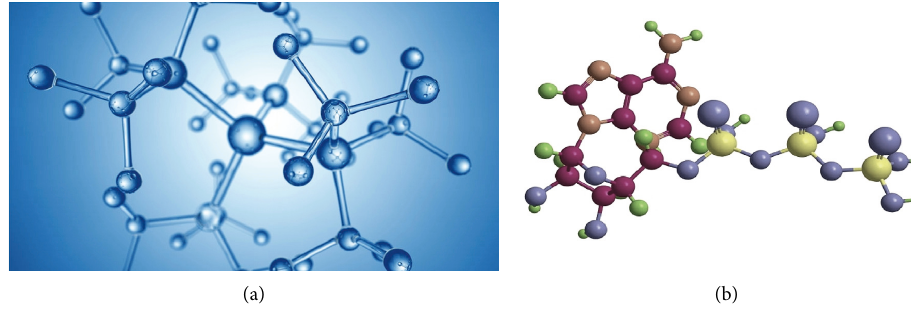
Figure 3: The structure of supramolecular